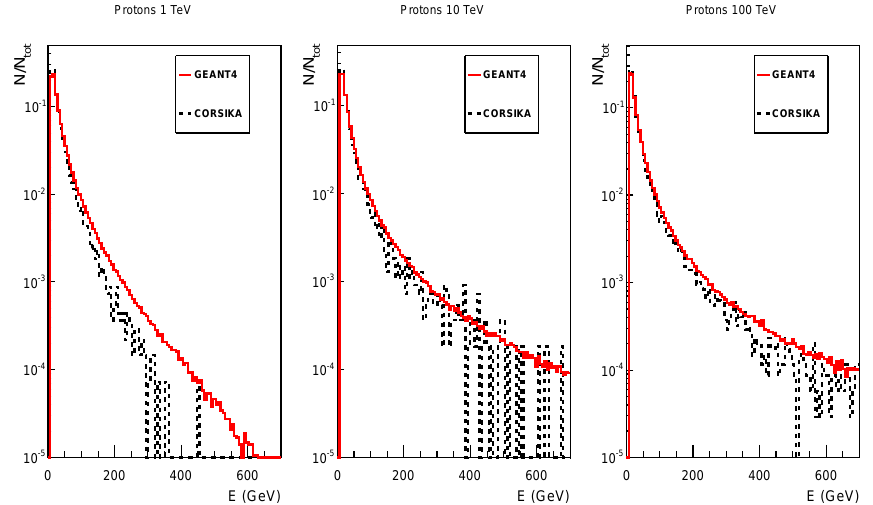
Fig. 2. Energy distributions of the muons at z = 870m as obtained with CORSIKA (dashes) and GEANT4 (solid line), normalised to the total number of muons produced in each simulation code.